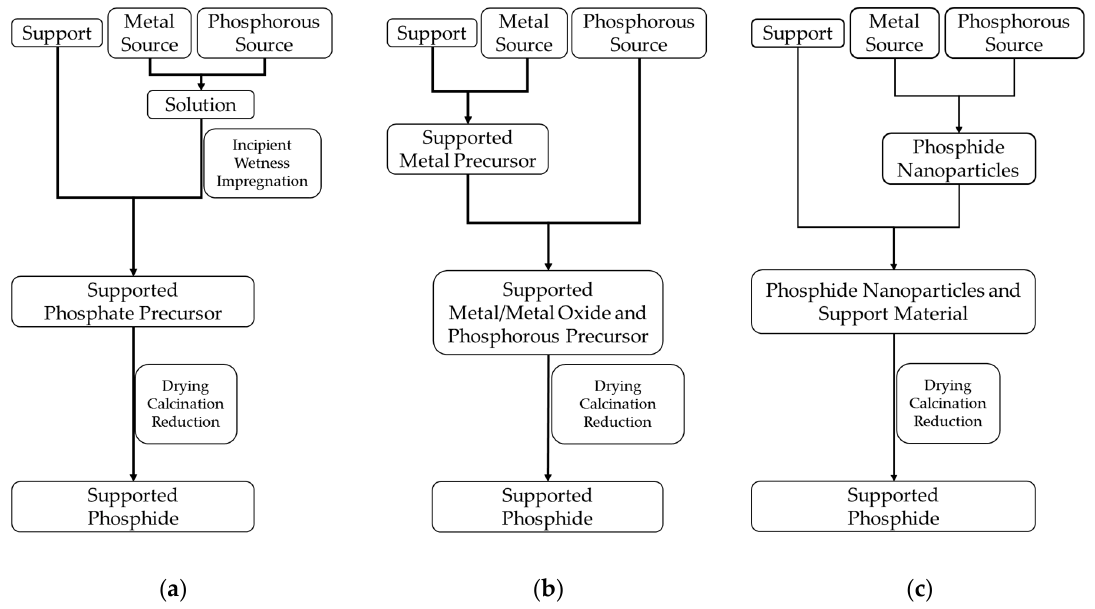
Figure 2. Schematic for the three main synthetic pathways for supported PGM phosphides: ( a ) Method of the incipient wetness impregnation; ( b ) Method of the conversion of a supported metal or metal oxide with a phosphorus precursor; ( c ) Method of the deposition of phosphide nanoparticles on the support material.